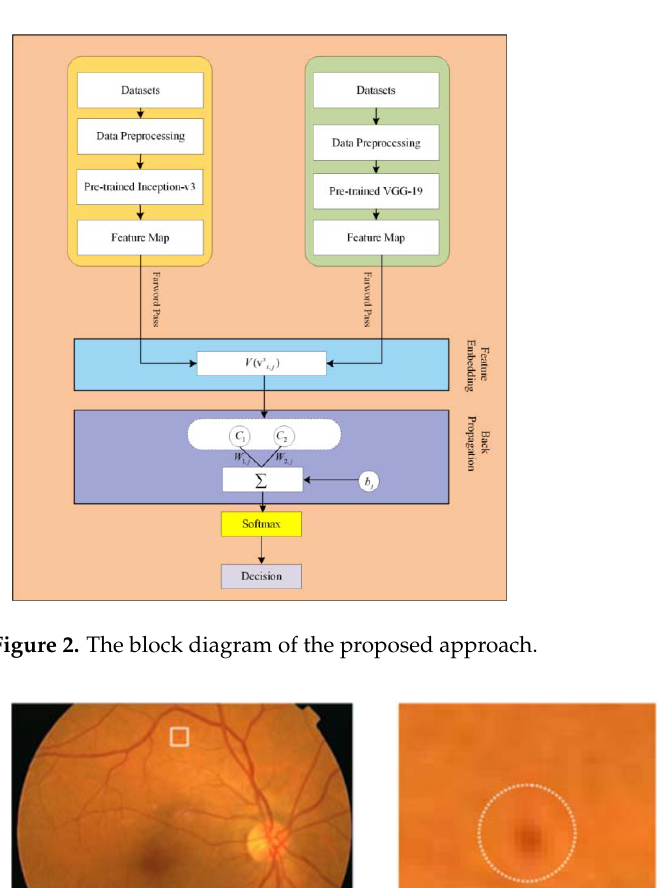
Figure 2. The block diagram of the proposed approach.